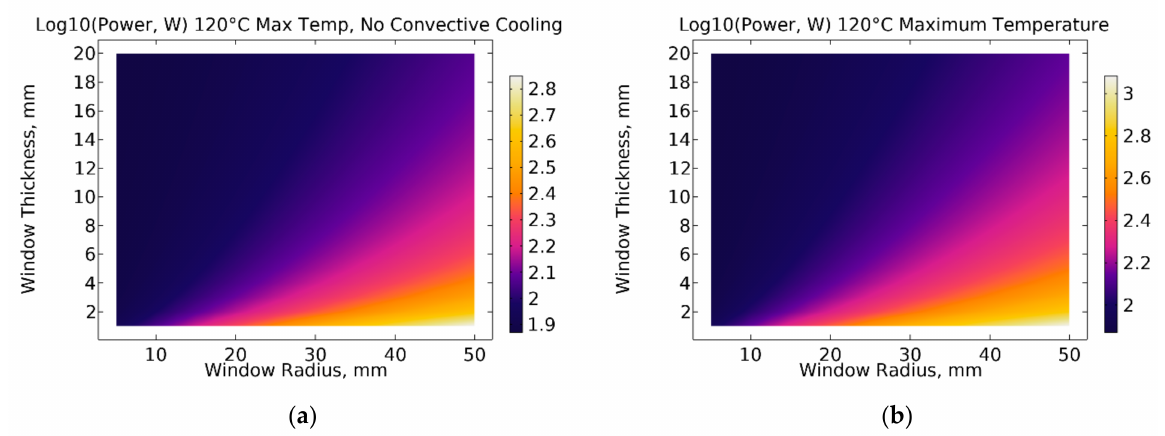
Figure 9. Simulation results for maximum 100 GHz CW transmitted power through the polymer windows without overheating. ( a ) the decimal logarithm of the maximum power value in watts without convective cooling (vacuum at both sides); ( b ) decimal logarithm of the maximum power value in watts with convective air cooling on one